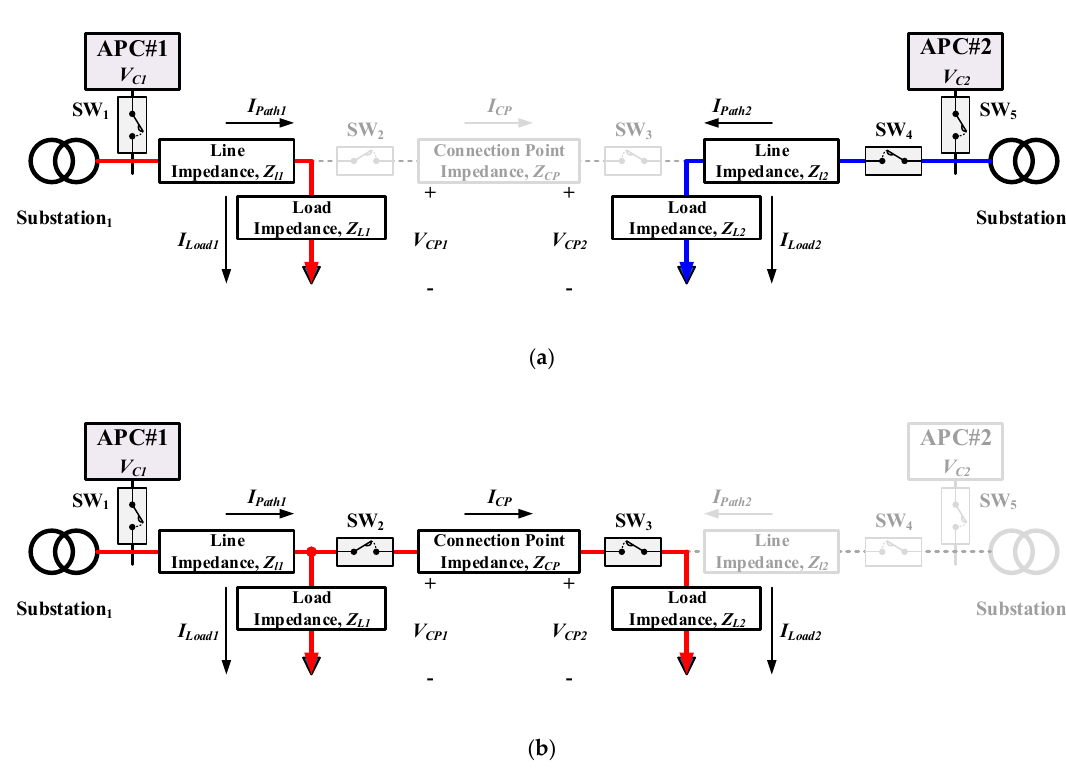
Figure 2. Distribution system reconfiguration: ( a ) before; ( b ) after.